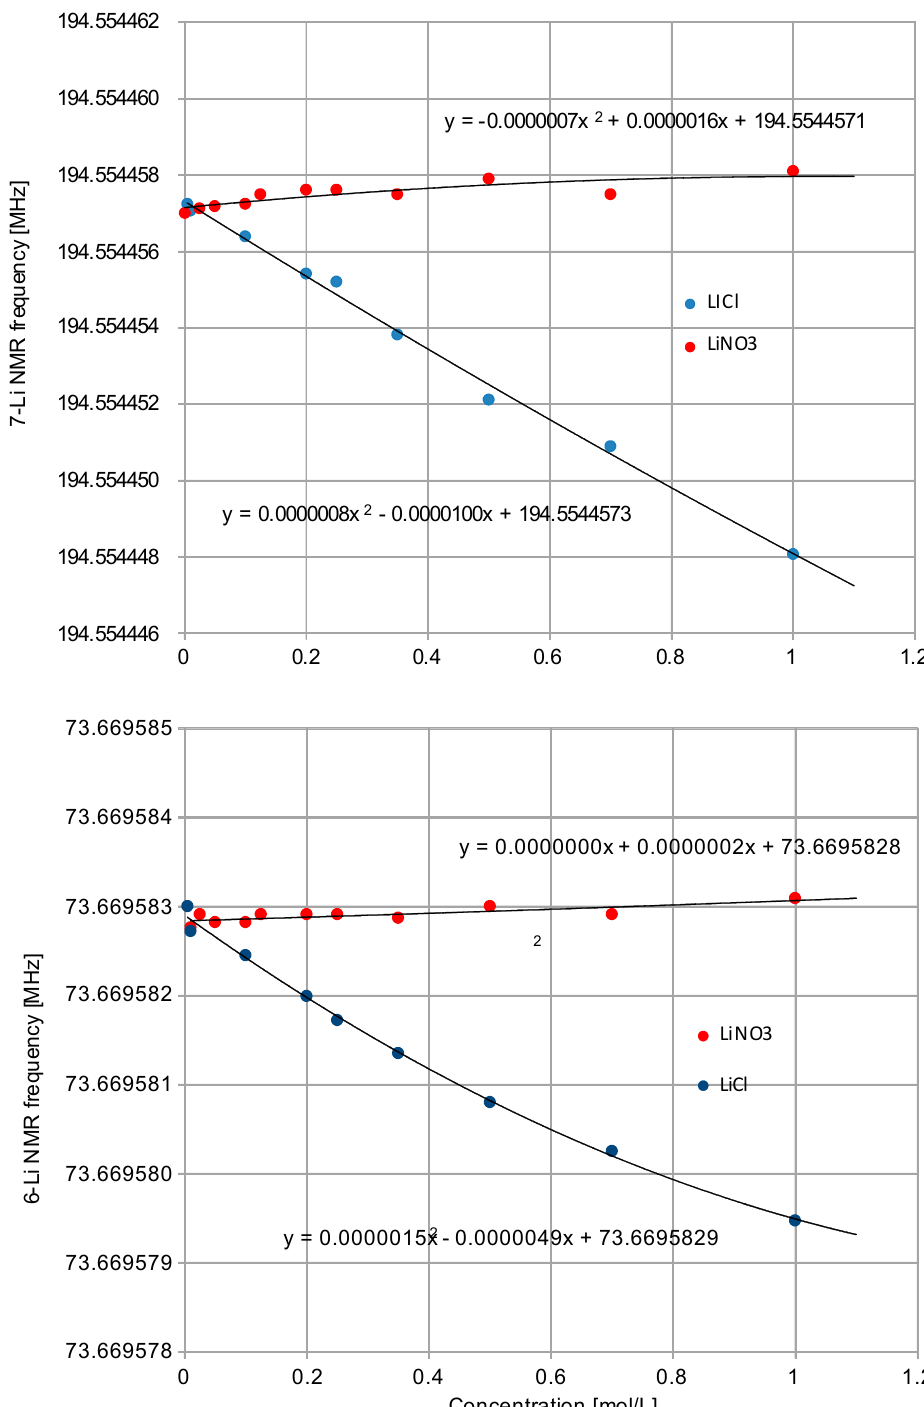
Figure 1. 6 Li and 7 Li NMR frequencies versus concentration of LiCl and LiNO 3 in water solutions.